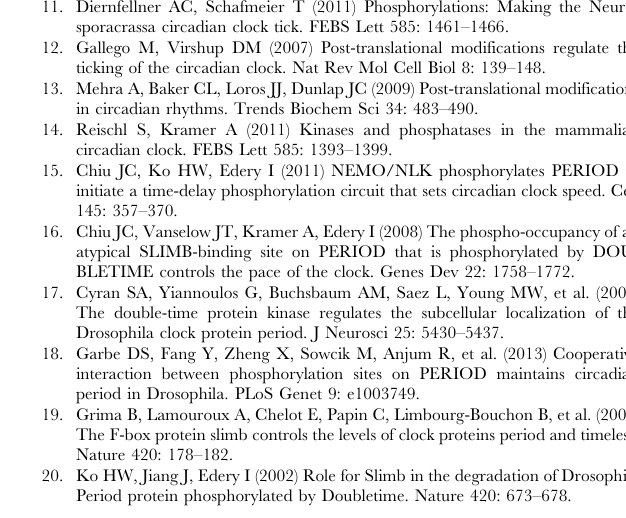
Figure S2 Stability of dCLK-WT and dCLK-16A protein in S2 cells. (A, B) S2 cells were transiently transfected with 300 ng of pMT-HA- dClk (WT) or pMT-HA- dClk -15A (15A) singly (A) or in combination with 600 ng of pMT- dbt -V5 (B). Expression of dCLK and DBT was induced 24 hr after transfection by adding 500 m M CuSO 4 to the medium. 24 hrs post induction, 10 m g/ml of cycloheximide (CHX) was treated to inhibit translation. Cells were harvested at the indicated time points and protein extracts were subjected to immunoblotting. dCLK was visualized with anti-HA (3F10) antibody. Shown are the representative blots for each analysis and relative levels of dCLK proteins were determined by measuring band intensities of immunoblot using image J software. (TIF) Figure S3 dCLK-15A manifests similar alterations as dCLK- 16A compared to dCLK-WT in terms of stability and transcrip- tional activity in S2 cells. (A) S2 cells were transiently transfected with 500 ng of pMT-HA- dClk (WT) or pMT-HA- dClk -15A (15A). Expression of dCLK was induced 24 hr after transfection by adding 500 m M CuSO 4 to the medium. Cells were harvested 24 hr after induction and protein extracts were first subjected to immunoprecipitation using anti-HA (12CA5) antibody and immune complexes were incubated in the absence ( 2 ) or presence ( + ) of l phosphatase followed by immunoblotting. (B) Shown are the average values from three independent experiments for relative E box dependent luciferase activity in the absence (BL) or presence Figure S4 (A–D) Representative daily locomotor activity patterns of p{ dClk -WT}; Clk out and p{ dClk -15A}; Clk out flies in light/dark cycles. Adult flies of the indicated genotype (as indicated, top of panels) were entrained with 12 hr:12 hr light:- dark cycles for 4 days followed by 8 days in DD. Black and white bar on top of each actogram indicates when lights were off and on, respectively. Red arrowhead indicates when DD starts. The vertical black bars on each row of the actogram depict the activity of the fly (measured in 30 min intervals). To better visualize rhythmic behavior, each day’s worth of activity recordings was double plotted. HD, hash density of the actogram. Figure S5 (A–D) Representative daily locomotor activities of p{ dClk -WT}; Clk out and p{ dClk -15A}; Clk out flies in temperature